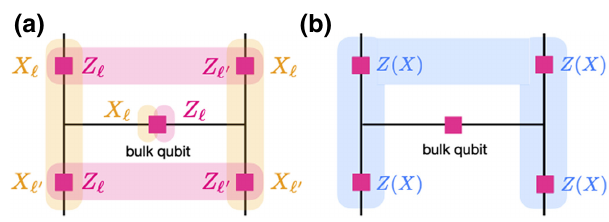
FIG. 7. An “ H ”-shaped surface-code lattice with five qubits. (a) The gauge generators consist of a single Z (cid:2) ( X (cid:2) ) operator on the bulk qubit together with pairs of Z (cid:2) Z (cid:2) (cid:5) operators on consecu- tive edges along the top and bottom boundaries (magenta shaded) and pairs of X (cid:2) X (cid:2) (cid:5) operators on consecutive edges along the left and right boundaries (orange shaded). (b) The global code with stabilizers ZZZZ ( XXXX ) (blue